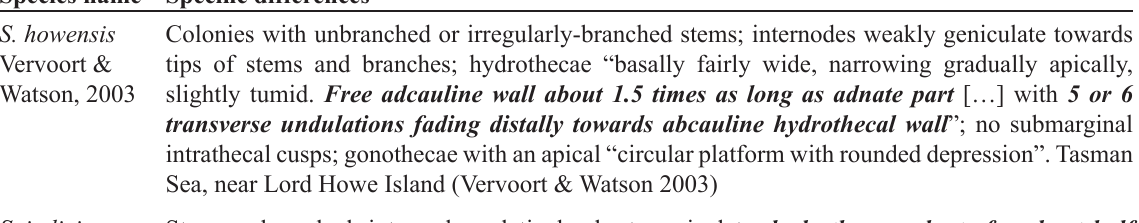
Table 9. Species of Symplectoscyphus with transversely-ridged hydrothecae and their differences to S. acutustriatus Galea,